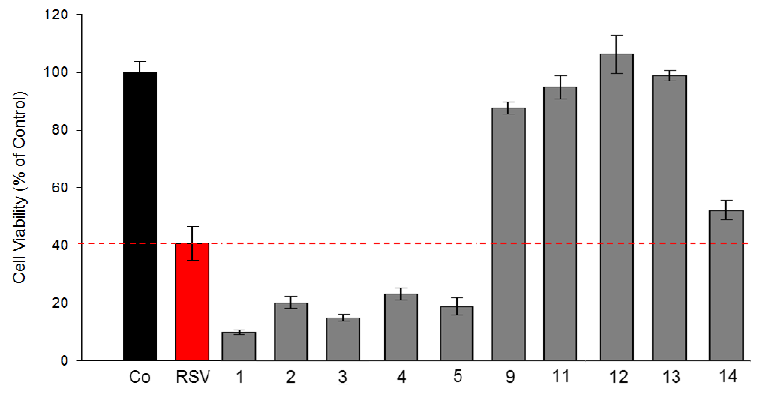
Figure 5. Effect of stilbene derivatives on human cancerous colorectal SW480 cell viability. Cells were grown for 48 h in the presence of 30 µM resveratrol (or no RSV in a control experiment) or 30 µM stilbene derivatives (numbered on the x-axis). Cell viability was determined by counting cells using the trypan blue test (Co: cells control test). Data correspond to the mean of two independent